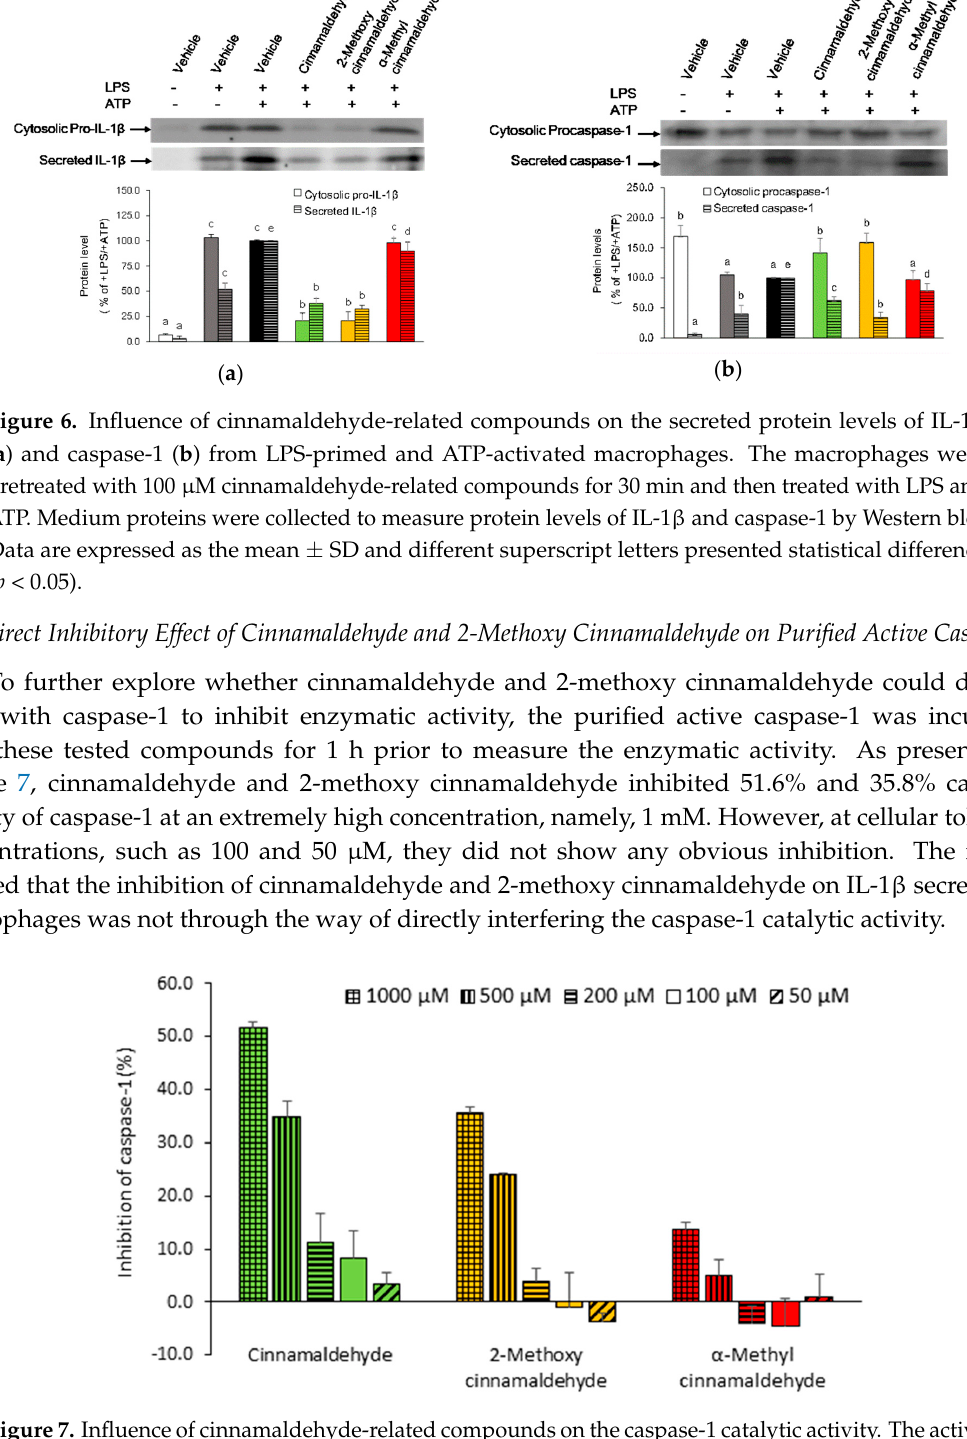
Figure 7. Influence of cinnamaldehyde-related compounds on the caspase-1 catalytic activity. The active caspase-1 were incubated with cinnamaldehyde-related compounds at concentrations from 50 to 1000 µ M for 1 h. The suppressing ability was expressed as % of reduction on caspase-1 catalytic activity.